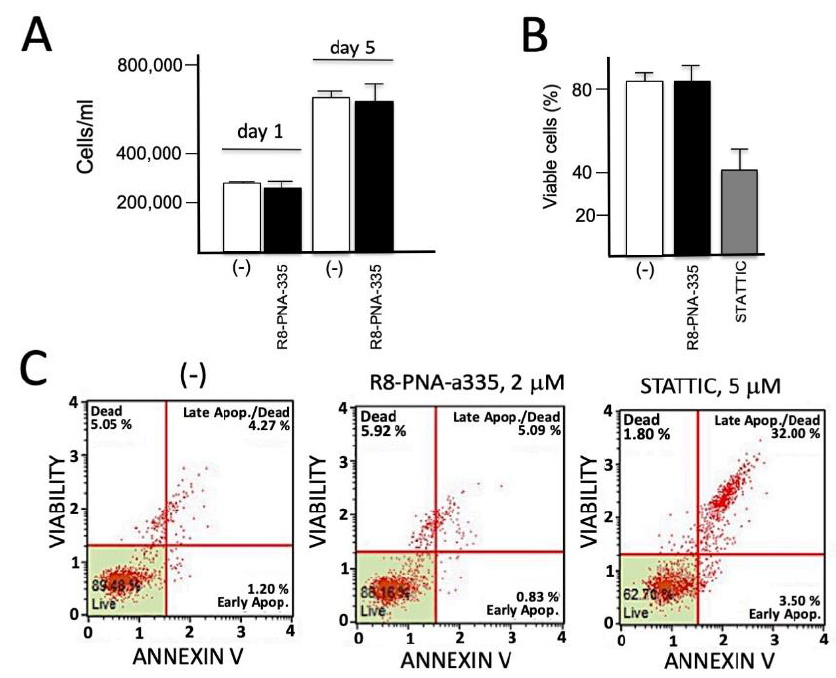
Figure 6. Effects of R8-PNA-a335 on cell growth, vitality, and apoptosis. ( A ) Calu-3 cells were cultured in the absence or in the presence of R8-PNA-a335 (4 µ M) for different days and the cell number/mL determined. ( B , C ) Effects of R8-PNA-a335 on vitality ( B ) and apoptosis ( C ) of Calu-3 cells. Vitality was determined by trypan blue analysis of dead cells; apoptosis by the Annexin V & Dead Cell Kit (Merk Millipore). Red dots = cells. The green boxes include live, non apoptotic cells.